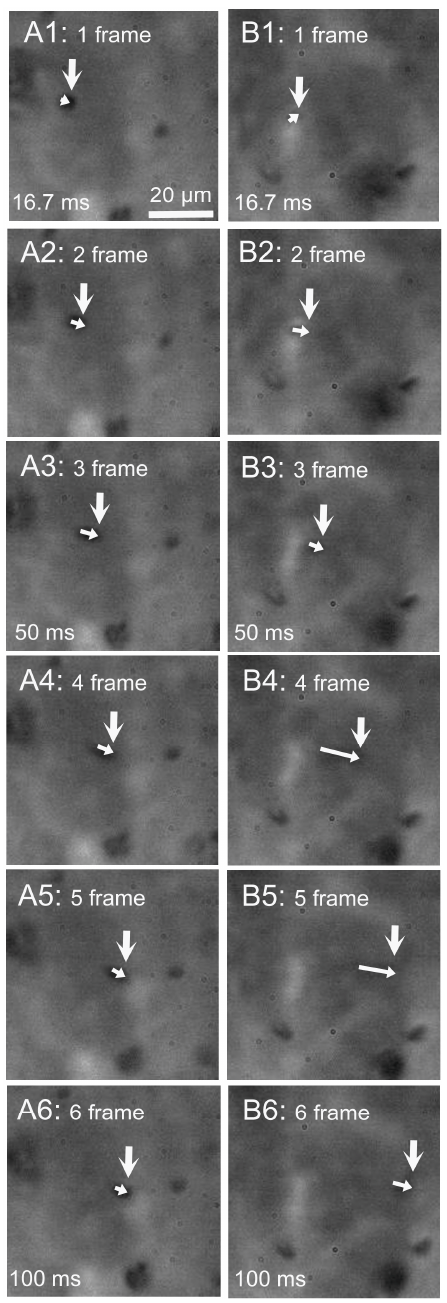
Figure 7. Movement of a latex microbead driven by beating cilia of a cHNECs. Experiments were carried out in the CO 2 /HCO 3 − -free solution. Movement of a microbead was recorded by a high-speed camera (60 fps). Panels A1–6 and B1–6 show six consecutive images taken every 16.7 ms. ( A ) Before daidzein stimulation. ( B ) Five min after daidzein stimulation. The initial position of the microbead is marked by a large white arrow in panels A1 and B1. Small white arrows in panels A1–6 and B1–6 show the movement of a latex microbead driven by the surface fluid flow for 16.7 ms. Stimulation with daidzein enhanced the microbead